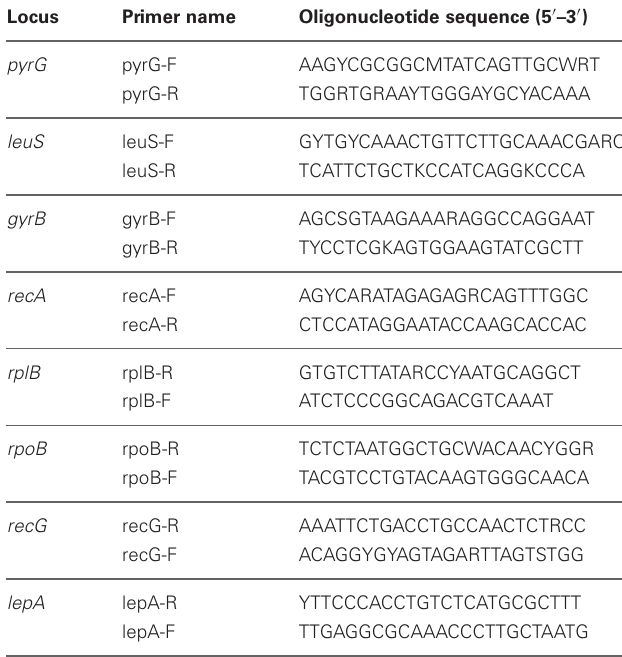
Table 2 | Oligonucleotide primers for the amplification of universally conserved protein coding genes from Thermoanaerobacter uzonensis